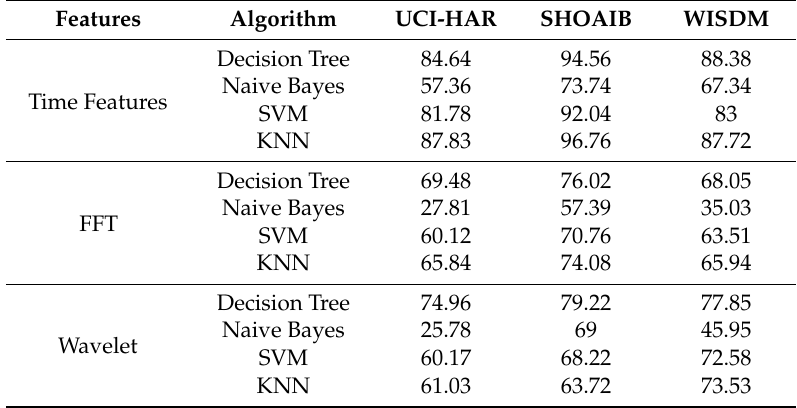
Table 3. Results regarding the accuracy of the classification models generated by the shallow algorithms combined with the time and frequency domain